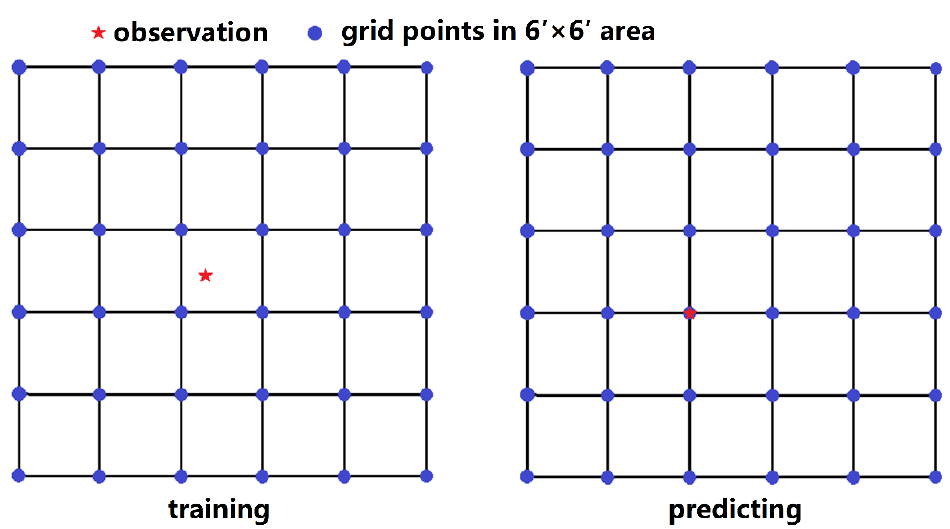
Figure 4. Observation points and surrounding grid points.